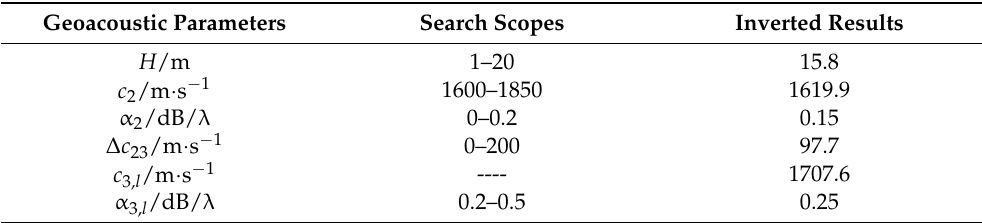
Table 2. Search scopes of geoacoustic parameters for wholly fluid bottom model and inverted results.